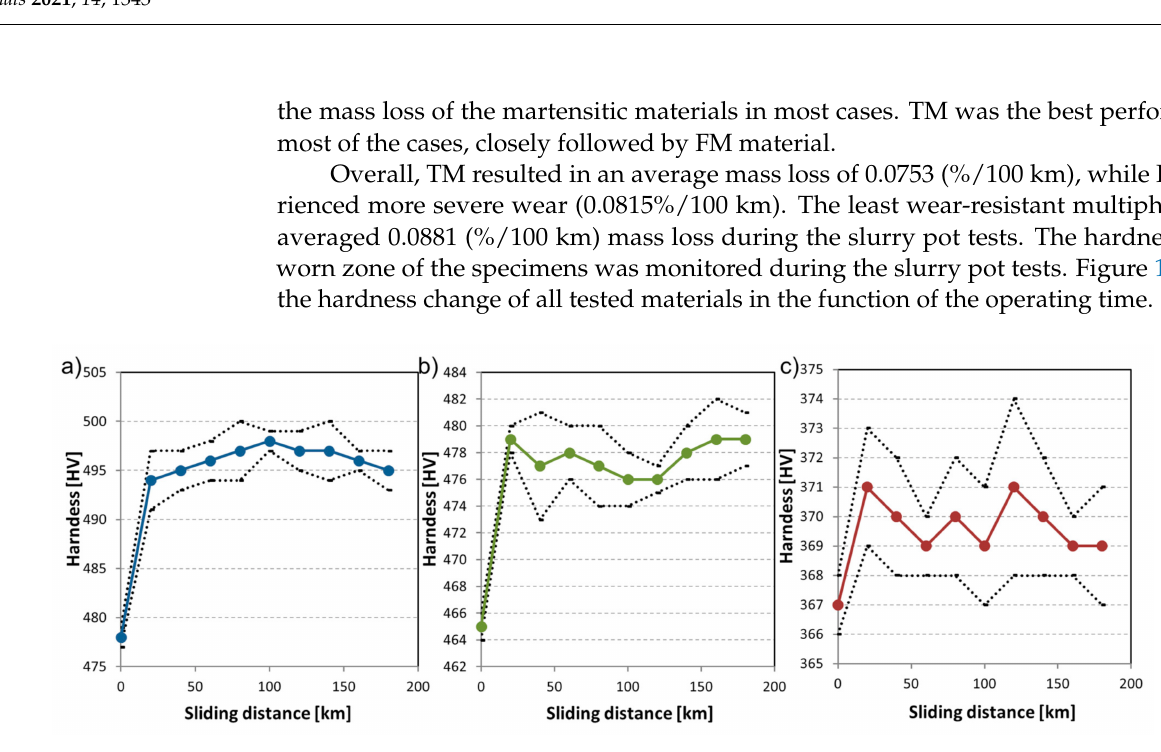
Figure 12. The hardness of tested slurry pot specimen in the function of wear testing time (sliding distance) ( a ) material FM, ( b ) material TM, ( c ) material MP.